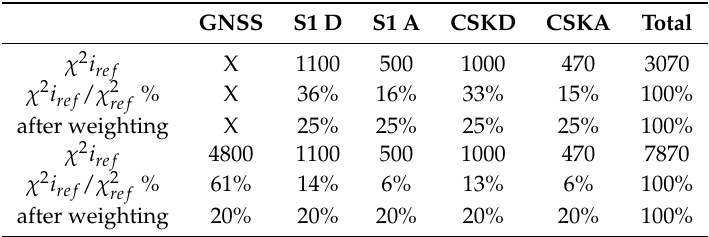
Table 3. Values of χ 2 Equation (6) and weight of each dataset in the computation of the misfit. The top ref three lines correspond to inversions conducted without the campaign and continous GNSS data, while the bottom three lines include the GNSS